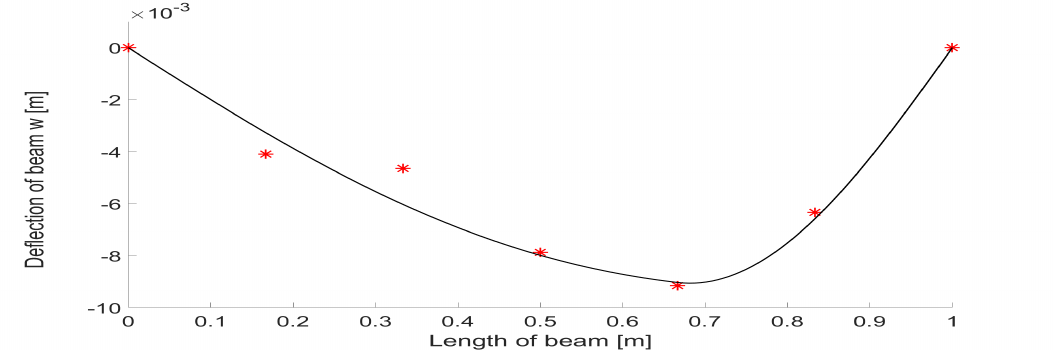
Figure 3. Deflection of the Gao beam for P = − 10 6 N q = − 4 × 10 6 Nm − 1 and ( E ∗ , ν ∗ ) . The asterisks stand for corresponding measured data z given in